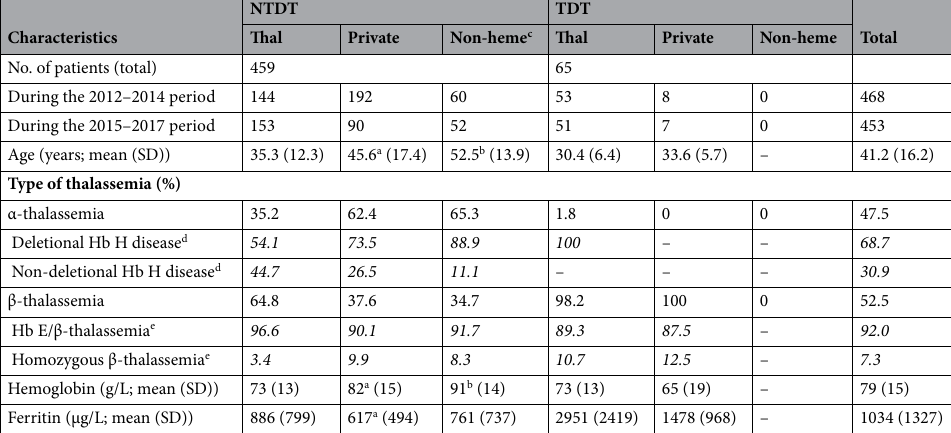
Table 1. Recent basic characteristics of the study population. a,b p < 0.05 comparing between Thal vs. Private and Thal vs. Non-heme groups, respectively. c No available ferritin in 33 patients. d,e The percentage within α-thalassemia and β-thalassemia,